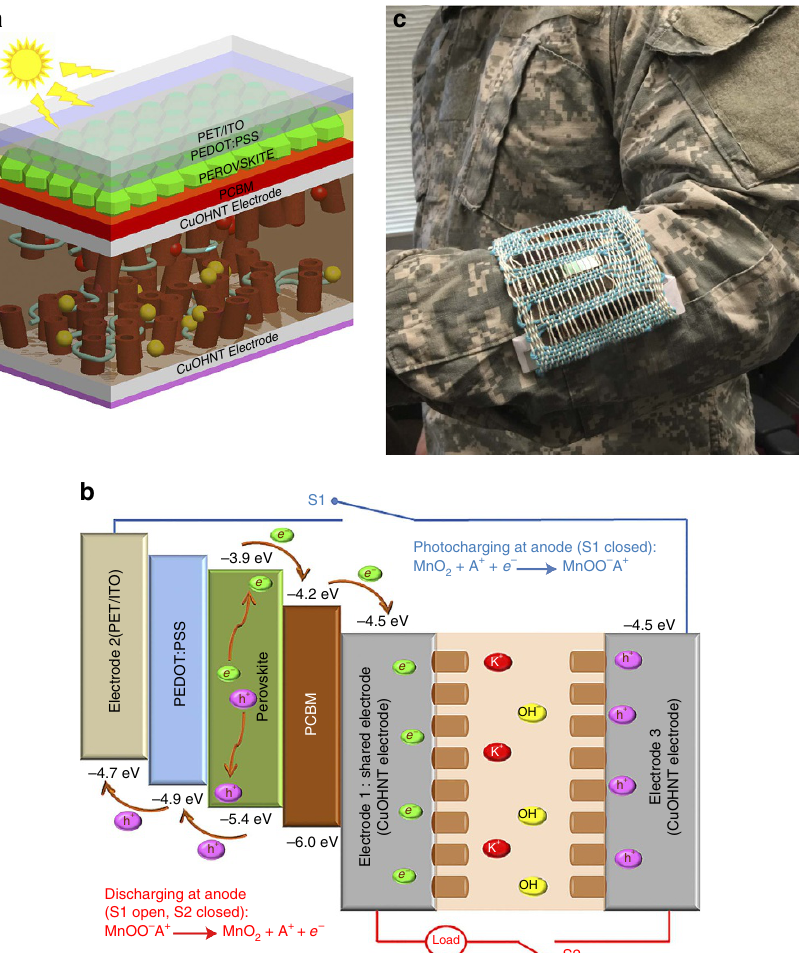
Figure 1 | Schematic illustration and charge transfer mechanism of ENHANS ribbons. ( a ) Schematic showing ENHANS ribbon consisting of the top PSCs and bottom SSC with shared copper electrode. This ‘bi-functional energy ribbon’ has been realized based on the copper ribbon as an anode (Electrode 1) for both PSCs and SSCs, while ITO/PET and another thin copper ribbon act as cathodes (Electrodes 2 and 3) for PSCs and SSC, respectively. ( b ) Charge transfer mechanism of the combination device: as ITO/PETand copper tape are connected to form close circuit (S1 closed), the photogenerated holes and electrons from PSCs flow into the cathode and anode of SSC, respectively. This current flow leads to the charging of SSC. The energy stored through the charging process can be discharged to do external work (S1 open and S2 closed). ( c ) A photograph showing a military uniform incorporating a lightweight fabric woven with ENHANS ribbons and cotton